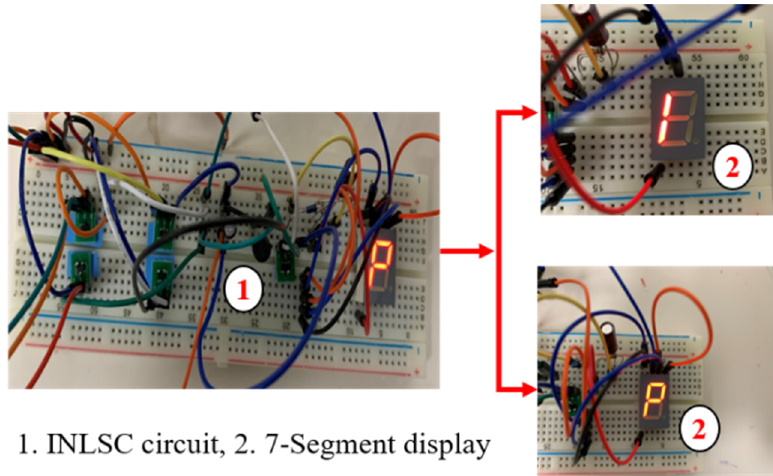
Figure 17. 7-segment display powered by PEH system through the proposed